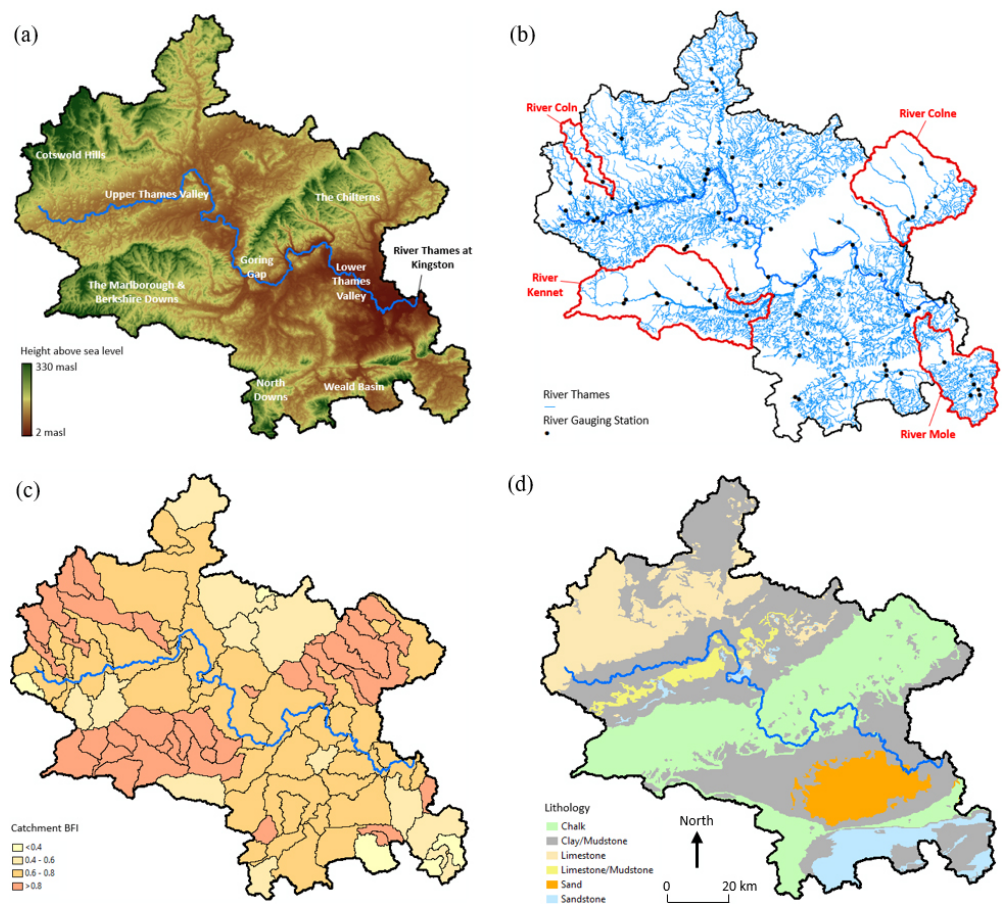
Figure 1. Maps of the Thames catchment showing the river Thames at Kingston main river flowing west to east, in relation to (a) the topography and key geographical locations, (b) the river gauging station network and key catchments referred to later in the text, (c) catchment baseflow index (National River Flow Archive (Marsh and Hannaford, 2008)), and (d) main bedrock lithology (after British Geological Survey, 2016). Contains British Geological Survey data © UKRI 2023 and Ordnance Survey data © Crown copyright and database right